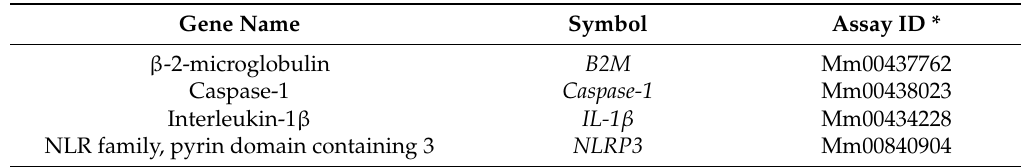
Table 1. Oligonucleotide primers used for real-time